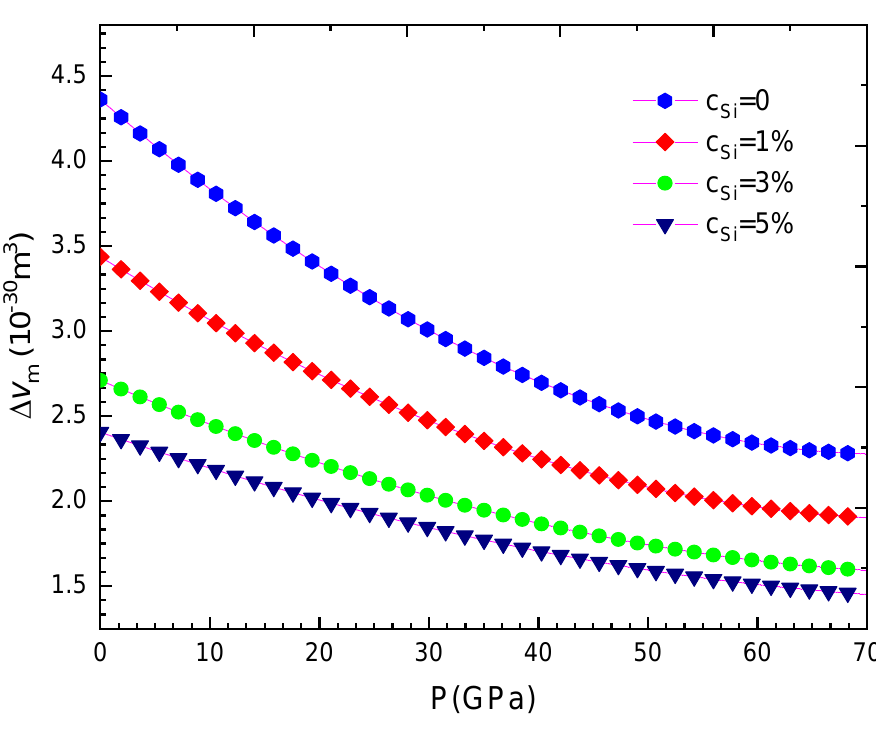
Figure 9. For WSi at T = 300 K.